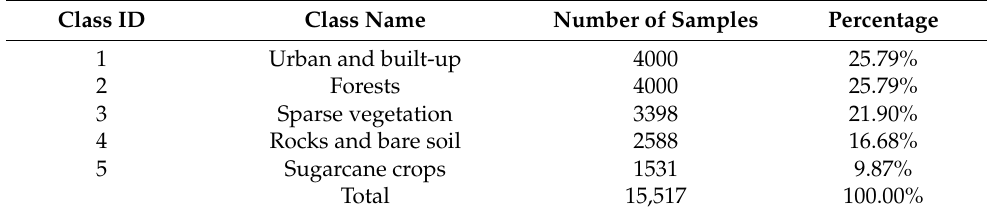
Table 1. The detailed class distribution on the Reunion Island